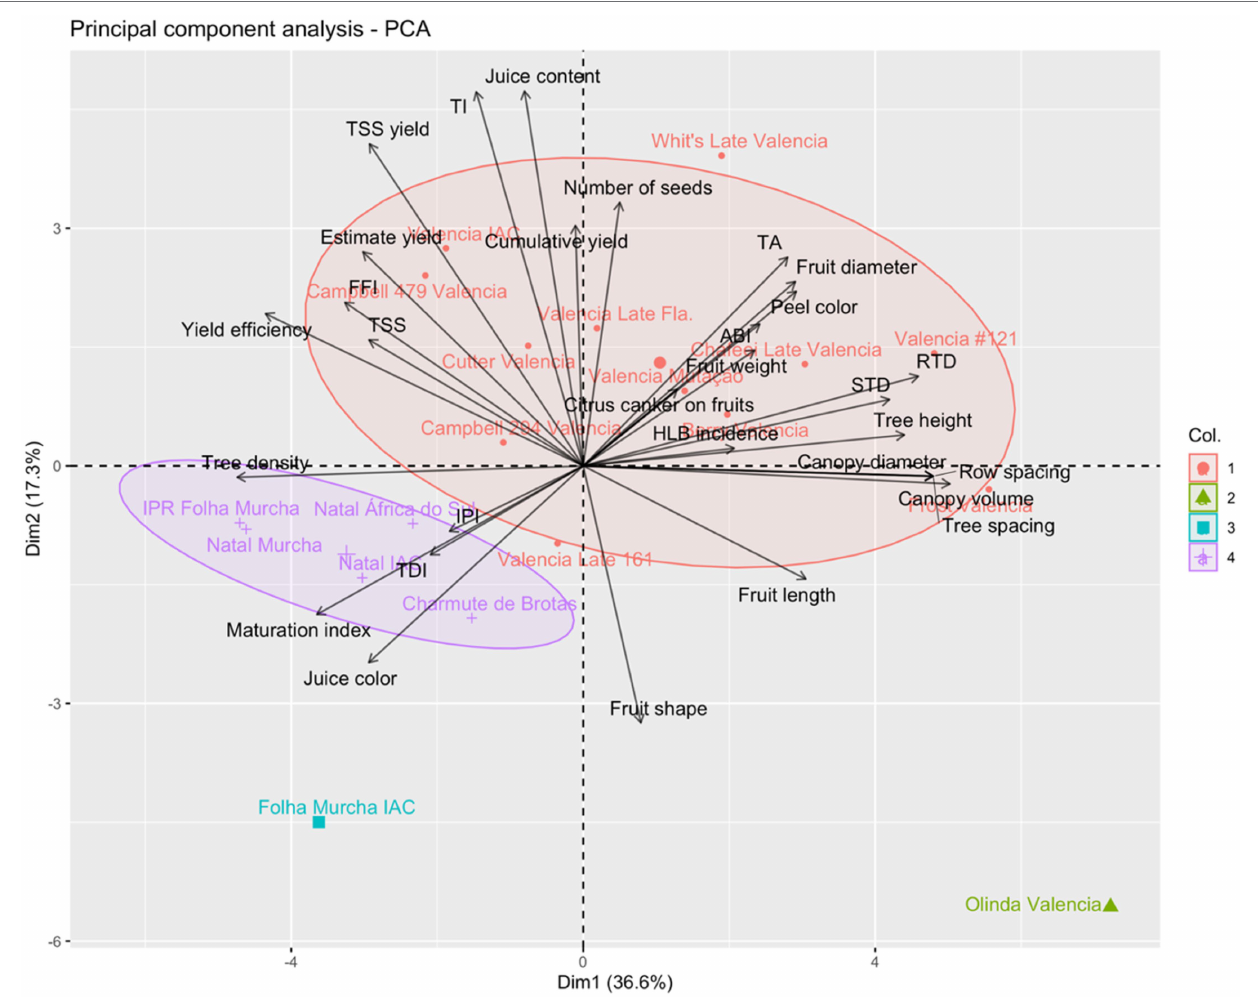
FIGURE 6 | Principal component analysis (PCA) for tree size, yield, fruit quality, estimation of plant density and yield, incidence of citrus canker on fruits, and incidence of huanglongbing (HLB) in trees of 19 late-season sweet orange selections grafted onto Rangpur lime rootstock. The variables were arranged according to their principal component scores and the individuals (sweet orange selections) were grouped into four distinct clusters (Col.): 1, 2, 3, and 4. Variables: tree height (m); canopy volume (m 3 ); canopy diameter (m); RTD – rootstock trunk diameter (cm); STD – scion trunk diameter (cm); TDI – trunk diameter index (STD.RTD − 1 ); cumulative yield (kg per tree); yield efficiency (kg.m − 3 ); ABI – alternate bearing index; row spacing (m); tree spacing (m); tree density (tree.ha − 1 ); estimate yield (t.ha − 1 ); TSS yield (t TSS.ha − 1 ); fruit length (mm); fruit diameter (mm); fruit shape; fruit weight; number of seeds per fruit; peel color (CCI); juice color (CCI); juice content (%); TSS – total soluble solids ( ° Brix); TA – titratable acidity (g.100 mL − 1 ); maturation index (TSS.TA − 1 ); technological index (kg TSS.box − 1 ); FFI – fresh fruit index; IPI – industrial processing index; incidence of citrus canker on fruits (%); and HLB incidence